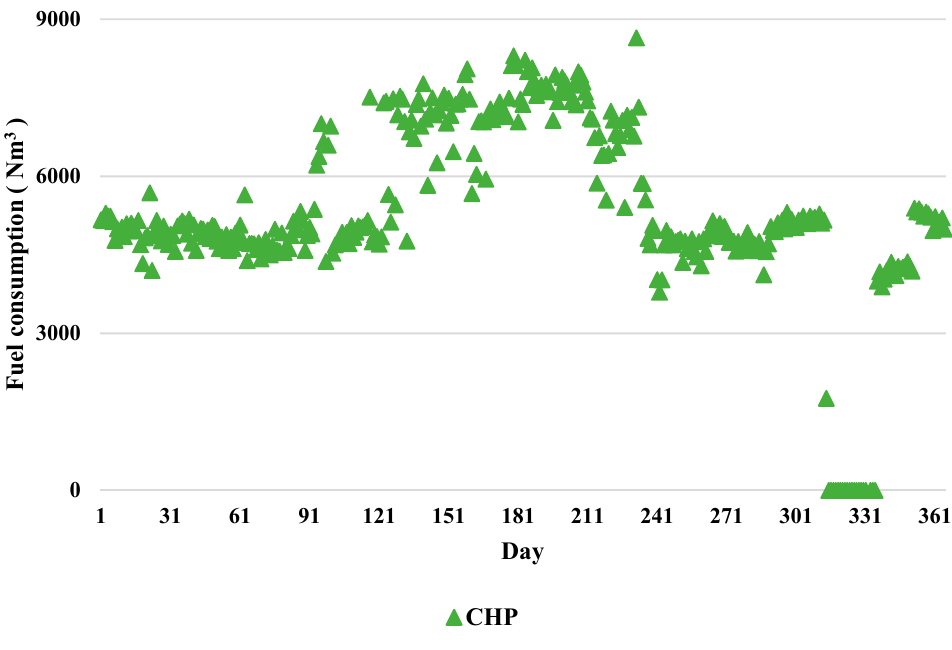
Figure 12. Amount of heat supply from the DHN for Case C. The daily and the monthly averaged daily operation hours for each prime mover are shown in Figure 13. Unlike the previous two cases, Case A and B, a slightly different op ‐